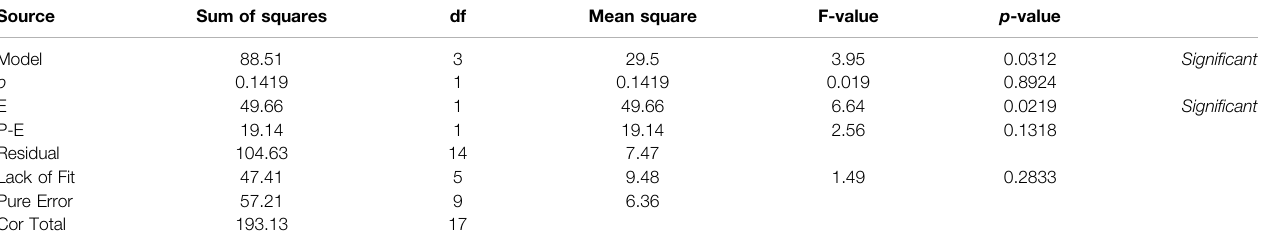
TABLE 1 | 2FI assessment for the effect of pressure ( p ) and decompression speed (E) on 7DHC measurements. Source